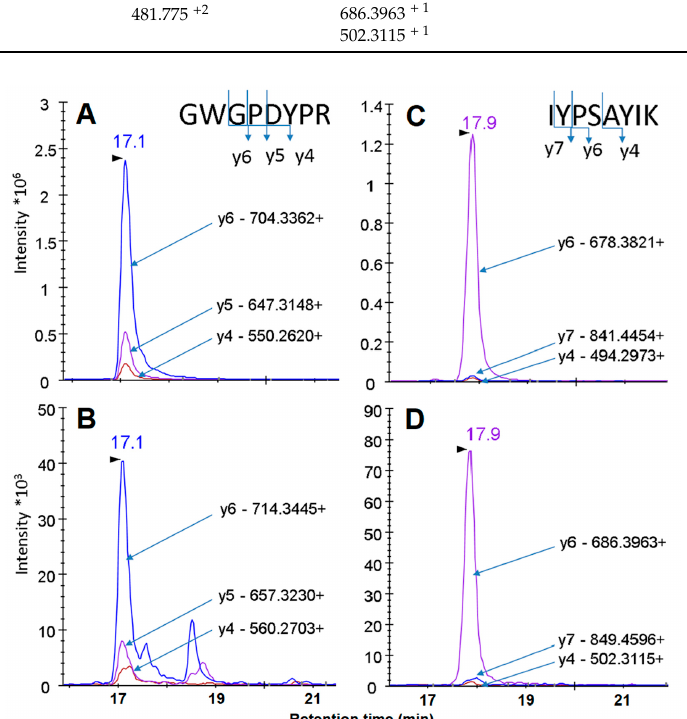
Figure 1. SRM spectra of proteotypic peptides GWGPDYPR (panels A and B ) and IYPSAYIK (panel C and D ) of SMAD4. Panels A and C : native peptides; panel B and D : isotope-labeled peptides (internal standards). Spectra were visualized with Skyline 3.6.0 software. The retention time for the major peak indicated by the arrow is shown above the peak.